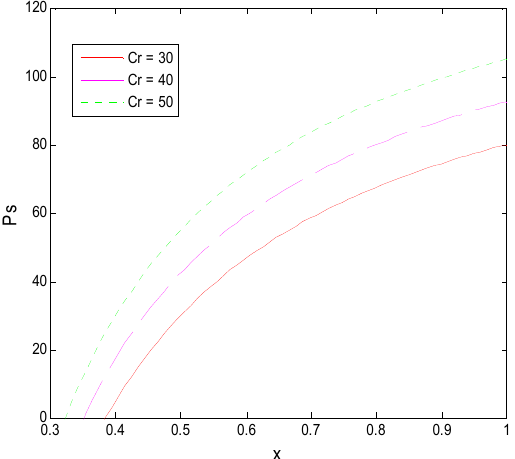
Figure 14. The effect of the transformation success rate on the technological transaction price.